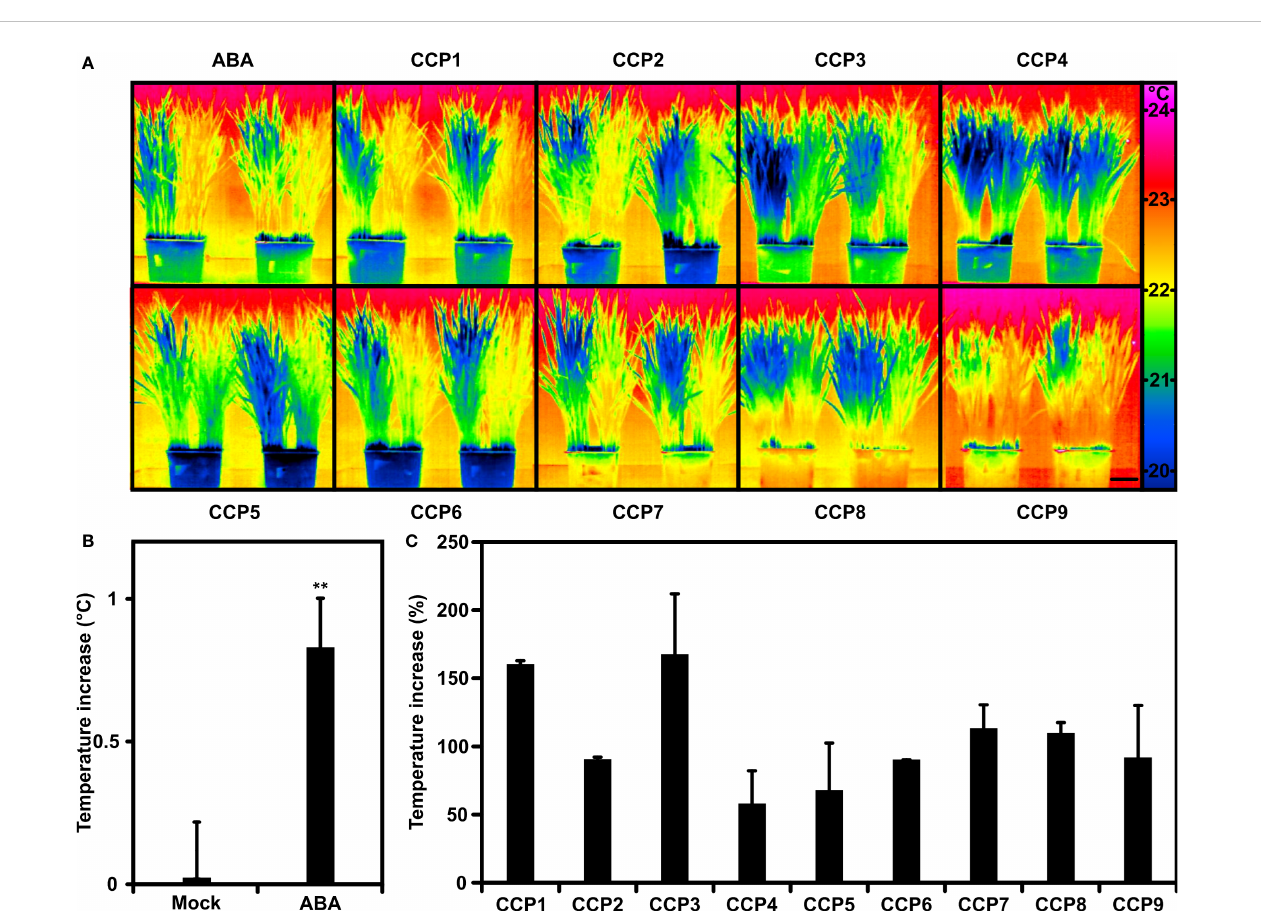
FIGURE 7 Wheat plants tuned into lowered transpiration by CCPs. (A) False-colour thermal images of wheat exposed to ABA and CCPs compared to mock treatment. Half of the plants grown in single pots were mock-treated with the solvent control (left half) or exposed to 100 m M ABA and ABA agonists as indicated (right half). Thermal images of 30-day-old wheat were taken 24 h after administration and two replicates are shown per treatment. (B) The leaf temperature increase of ABA-treated wheat in comparison to mock-treated plants. The leaf temperature difference was averaged from six independent experiments each having three biological replicates (leaf temperature of mock-treated plants, 22.1 ± 0.17°C; 20.7 ± 0.16°C; 21.9 ± 0.19°C; 21.4 ± 0.04°C; 21.7 ± 0.15°C; 21.8 ± 0.17°C). (C) Leaf temperature increase of CCP-treated plants relative to ABA-treated plants set to 100%. The temperature increase at 100 m M ABA was 0.6 ± 0.18°C for CCP1, 0.9 ± 0.19°C for CCP2 and CCP5, 0.6 ± 0.12°C for CCP3 and CCP4, 0.9 ± 0.03°C for CCP6, 0.9 ± 0.10°C for CCP7, and 0.9 ± 0.07°C for CCP8 to CCP9, respectively. The scale bar in (A) indicates 5 cm. (B) **P < 0.01 compared to mock-treated plants. (C) n = 3 biological replicates per treatment, mean ±